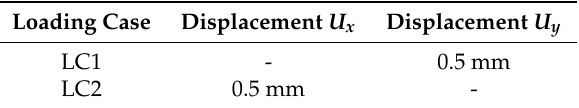
Table 1. Loading cases for the 3D and spring method